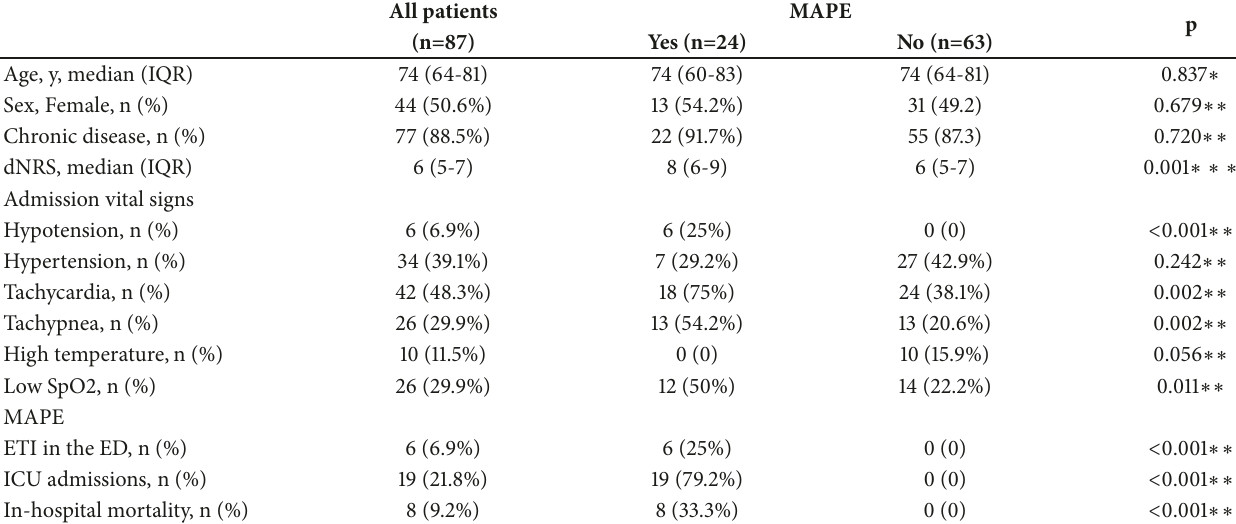
Table 1: Characteristics of study participants.